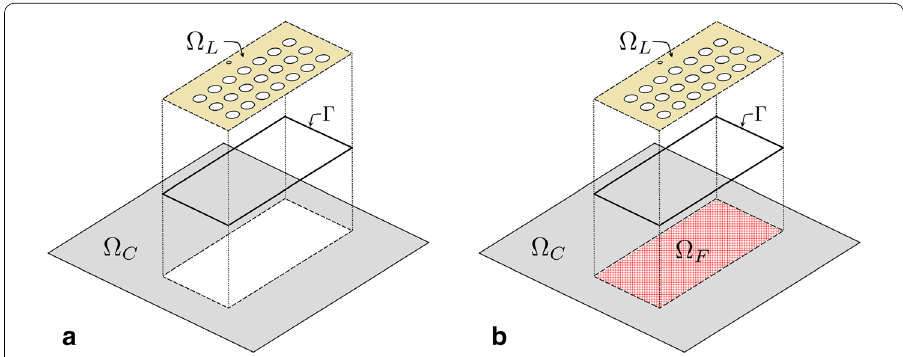
Fig. 3 Domain decomposition procedure: a the classic one, when (cid:3) is decomposed into local